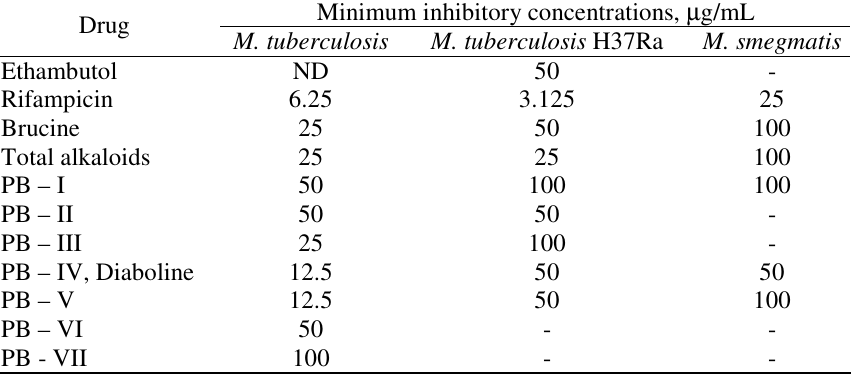
Table 3. In vitro antimycobacterial activity of S. potatorum alkaloid